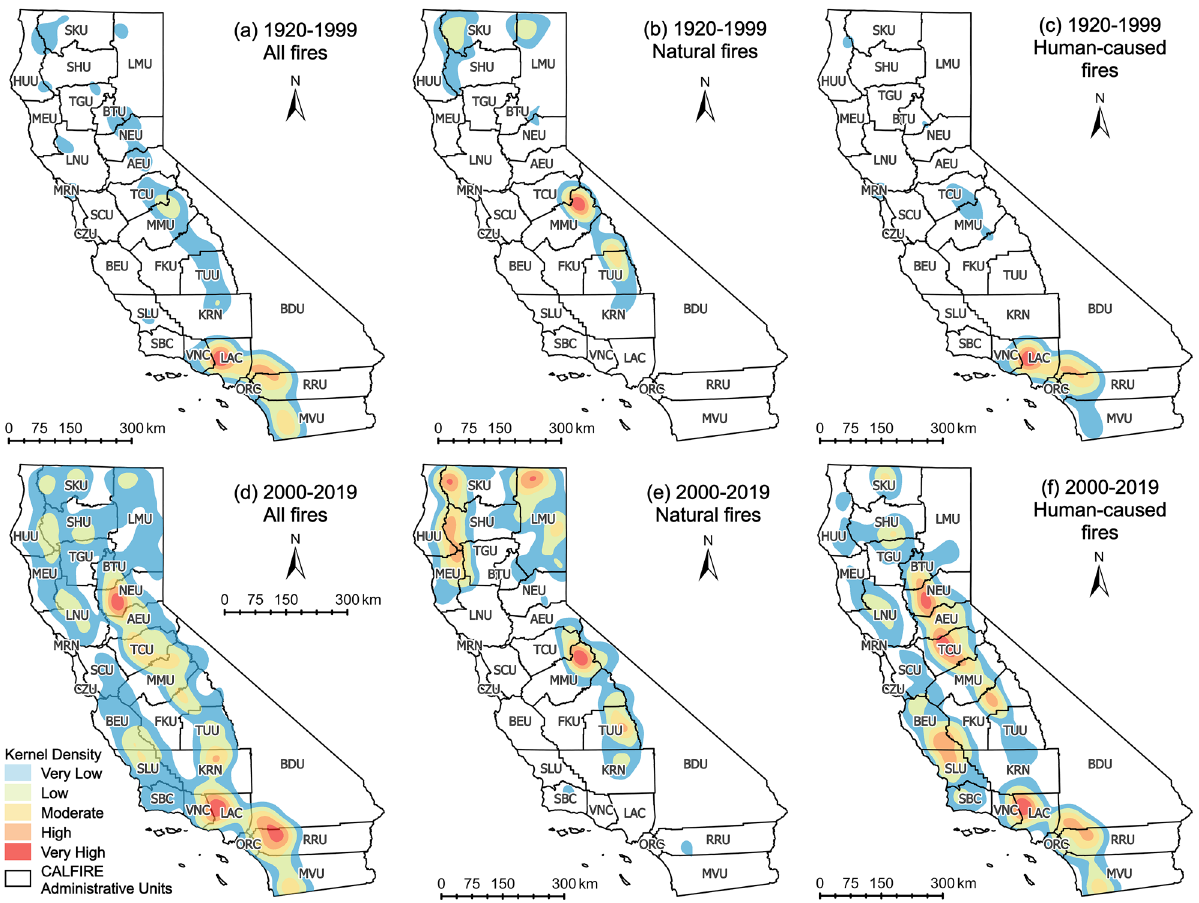
Figure 6. Kernel density distribution of wildfire occurrence in CA during 1920–1999 ( a – c ), and 2000–2019 ( d – f ). ( a – f ) are wildfire density distribution maps for all wildfires, natural wildfires and human-caused wildfires in CA,